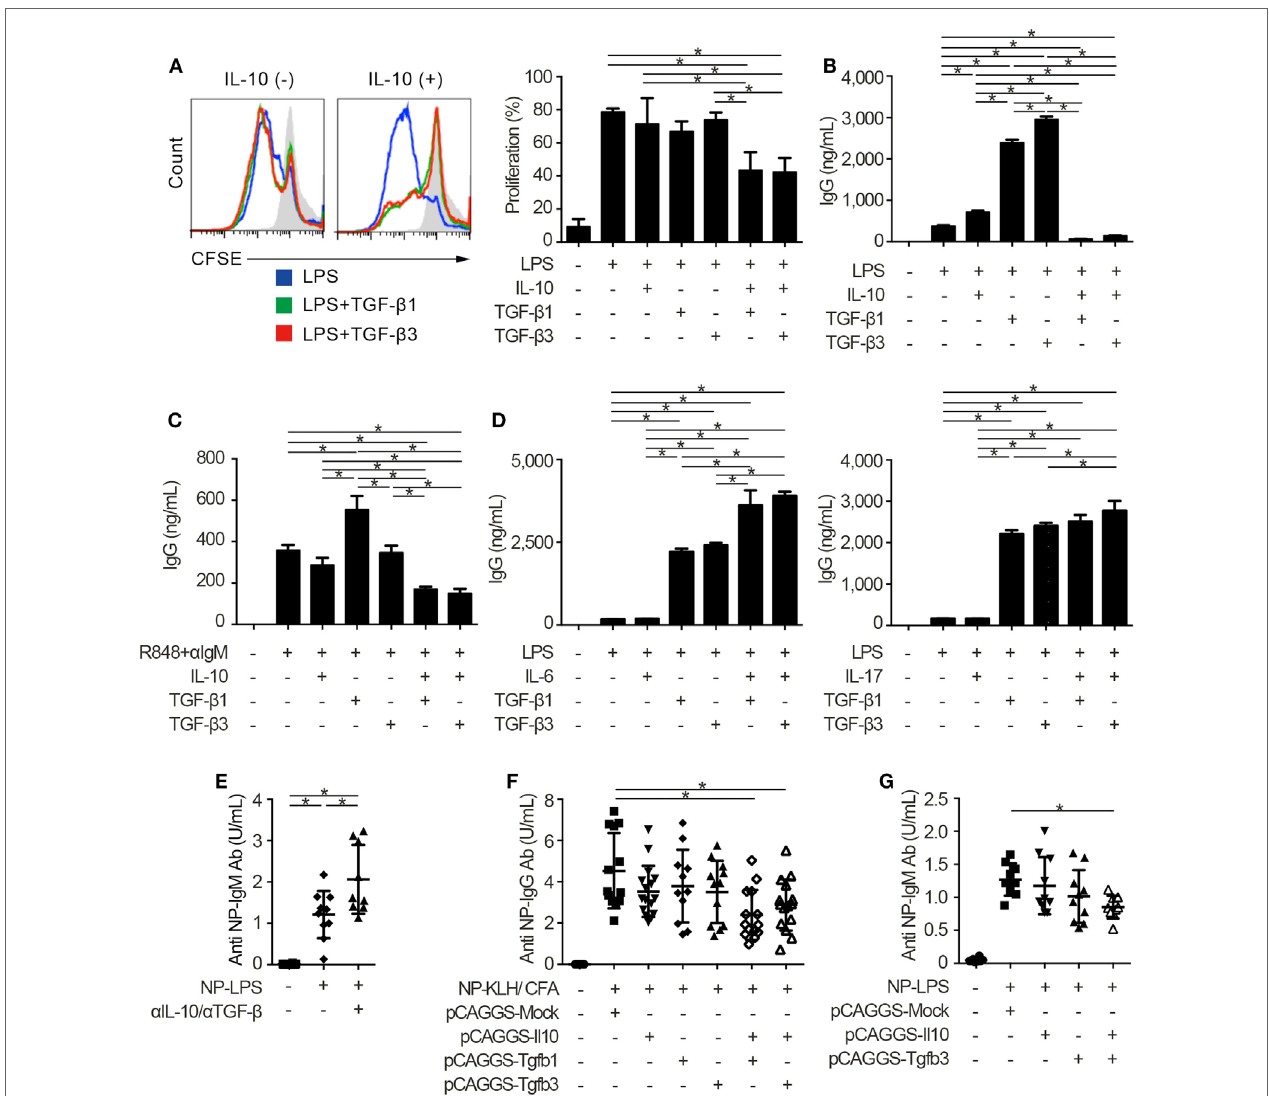
FigUre 2 | TGF- β and interleukin-10 (IL-10) synergistically suppress toll-like receptor-mediated humoral immune responses. (a) Histogram plots and percentages of CFSE-labeled B220 + B cells stimulated by 10 µg/ml lipopolysaccharides (LPS) either with or without 2 ng/ml TGF- β 1, TGF- β 3, and/or 50 ng/ml IL-10 for 3 days ( n = 3). (B) Total IgG antibody titers in the supernatants of 3 µg/ml LPS-stimulated B cells either with 10 ng/ml TGF- β 1, TGF- β 3, and/or 50 ng/ml IL-10 for 7 days were quantified by ELISA ( n = 3). (c) B cells were cultured under 200 ng/ml R848 and anti-IgM stimulation either with or without TGF- β 1 or TGF- β 3 for 7 days and total IgG antibody production was assessed by ELISA ( n = 3). (D) Total IgG antibody titer in the supernatants of B cells cultured with LPS and 25 ng/ml IL-6 (left) or 1 ng/ml IL-17 (right) either with TGF- β 1 or TGF- β 3 for 7 days ( n = 3). Data are representative of more than two independent experiments in (a–D) . (e) Serum anti-NP-bovine serum albumin (BSA) antibody titers from NP-LPS-immunized B6 mice treated with 300 µg anti-IL-10 antibody and 300 µg anti-TGF- β antibody were quantified by ELISA ( n = 9–10). (F,g) Anti-NP-BSA antibody titers from NP-KLH/CFA-immunized ( n = 11–16) (F) or NP-LPS-immunized ( n = 9–10) (g) mice with indicated pCAGGS plasmid vectors were quantified. P < 0.05 by one-way analysis of variance followed by Bonferroni’s multiple comparisons test (a–D) or Holm– Sidak’s multiple comparisons test (e–g) . Error bars,